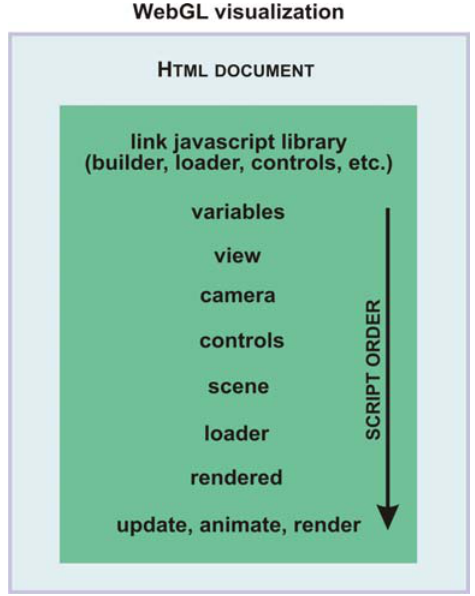
Figure 11. Structure of main HTML page of WebGL visualization environment